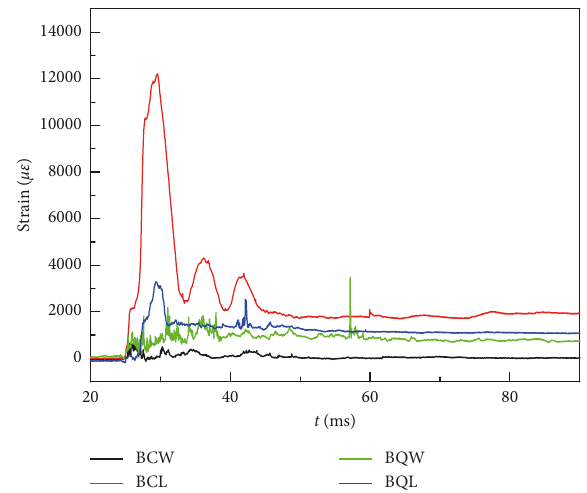
Figure 13: Reinforcement strain history of